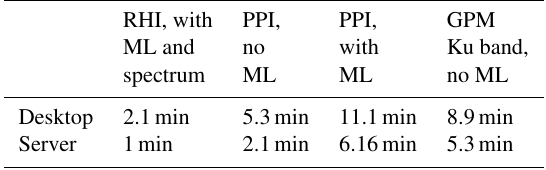
Table 4. Observed computation times for three types of scans and two computers. The desktop has an 8 core i7-4770S CPU with 3.1GHz (30.5GFlopss − 1 ) and 32GB of RAM, the server has a